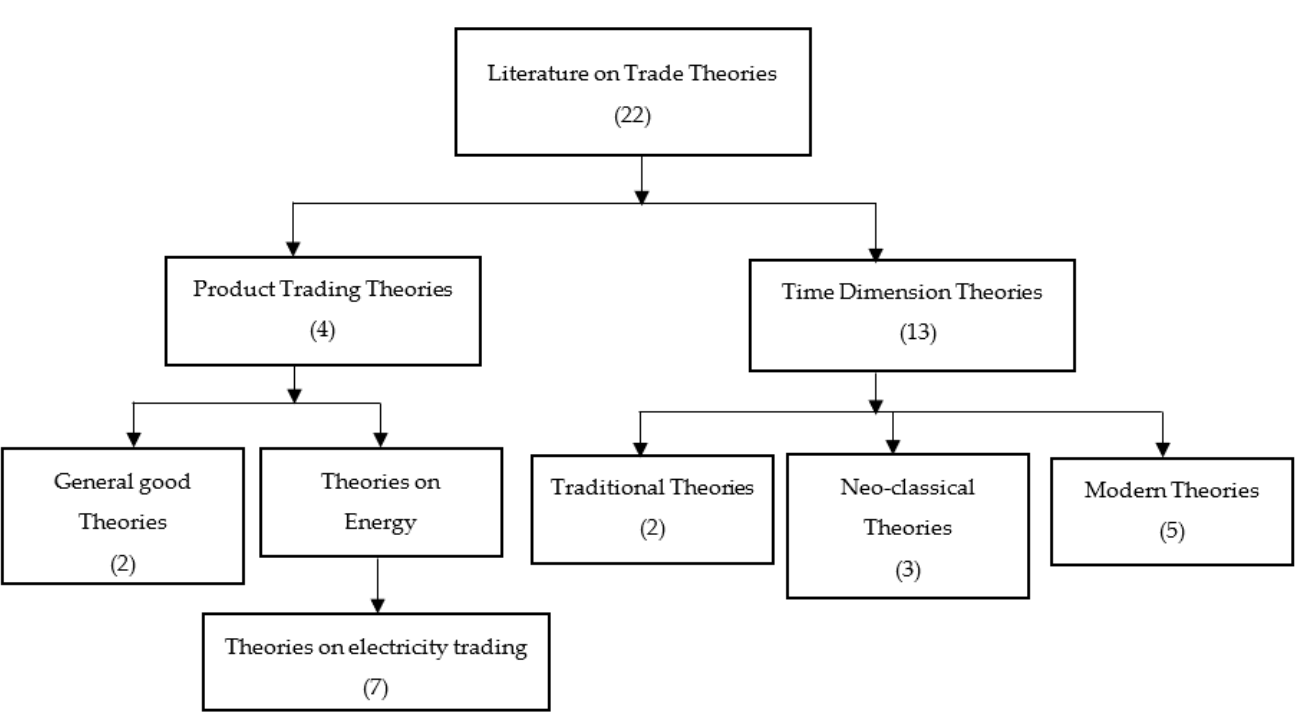
Figure 2. Review strategy on theories relating to electricity trading in EMI.